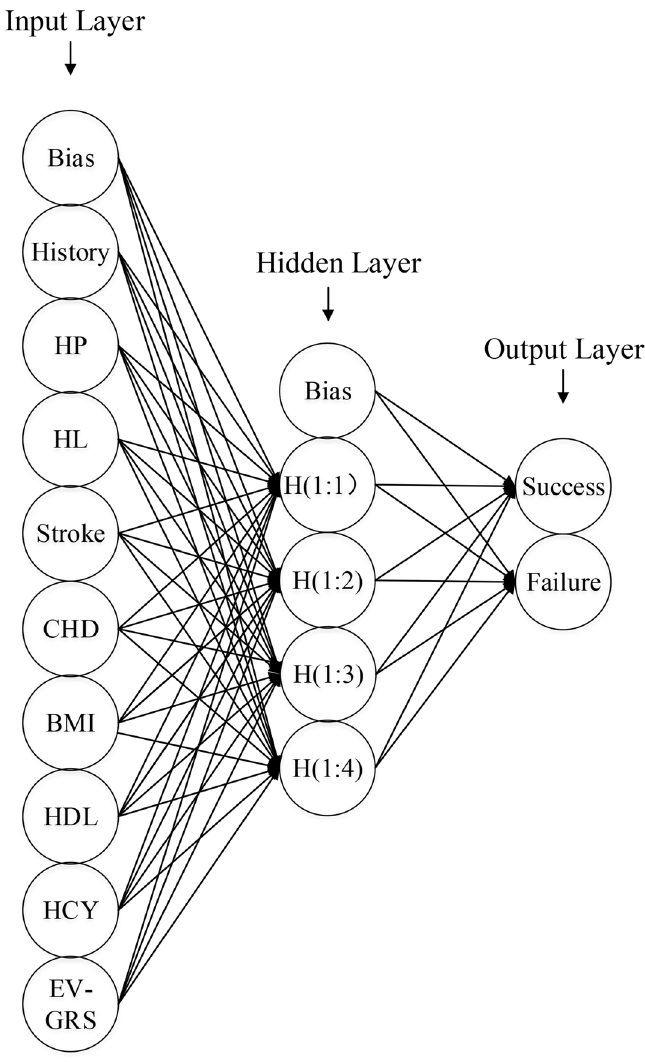
Figure 1. Schematic representation of the ANN model developed to predict the efficacy of folic acid therapy to